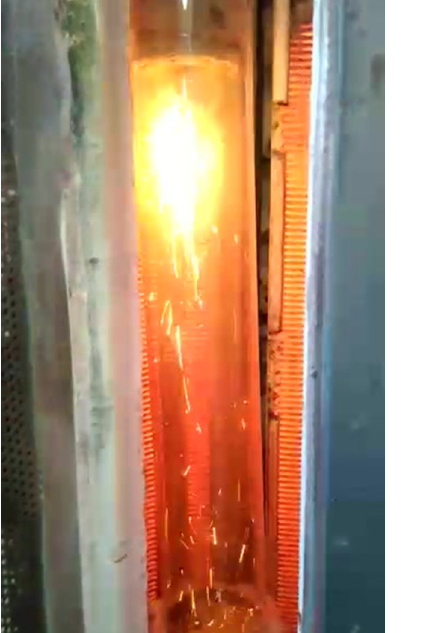
Figure 5. Estimation of the flame volume; a = 3.4 cm and c = 5.86 cm and A = 174 cm 2 [24].